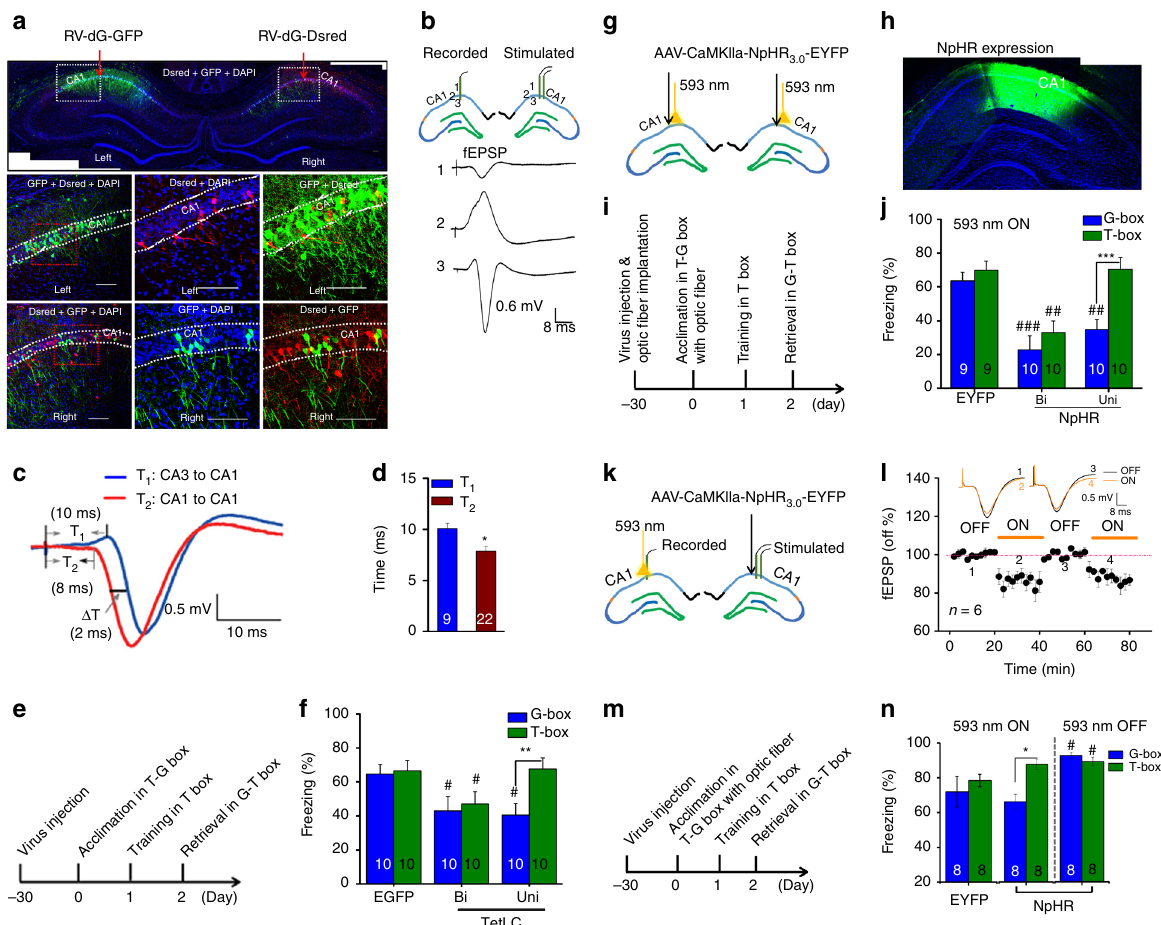
Fig. 3 The ipsCA-conCA1 functional connectivity. a RV-dG-GFP and -Dsred were infused into the stratum oriens of left and right CA1, and a number of neurons were labeled in the opposite side. b In vivo study revealed that electrical stimulation at ipsCA1 evoked the excitatory postsynaptic potentials (fEPSP) in conCA1, with an onset latency of about 8-ms ( c , d T2), relative to about 10-ms in the CA3-CA1 pathway ( c , d T1). e Paradigm for studying TetLC effects. f Unilateral (Uni) or bilateral (Bi) CA1 expression of TetLC (AAV-Syn-EGFP-2A-TetLC-3 fl g) impaired generalization or the both, respectively. g – j NpHR was expressed and optogenetic stimulation was used during the retrieval tests. Silencing of Uni or Bi CA1 impaired generalization or the